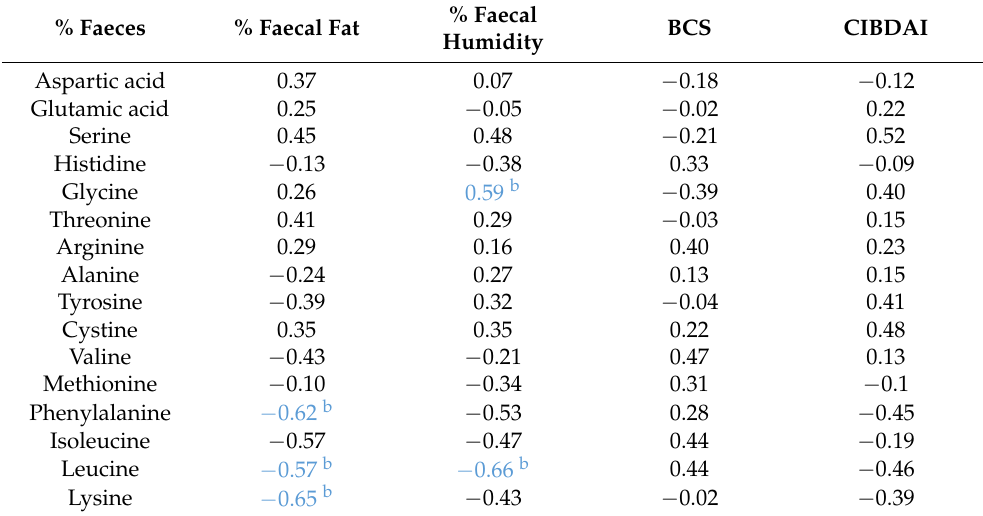
Table 3. Correlation coefficients between faecal amino acids proportions and faeces composition (% humidity, % fat), body condition score (BCS), and CIBDAI (canine inflammatory bowel disease activity index). % Faecal BCS CIBDAI % Faeces % Faecal Fat Humidity Aspartic acid 0.37 0.07 − 0.18 − 0.12 Glutamic acid 0.25 − 0.05 − 0.02 0.22